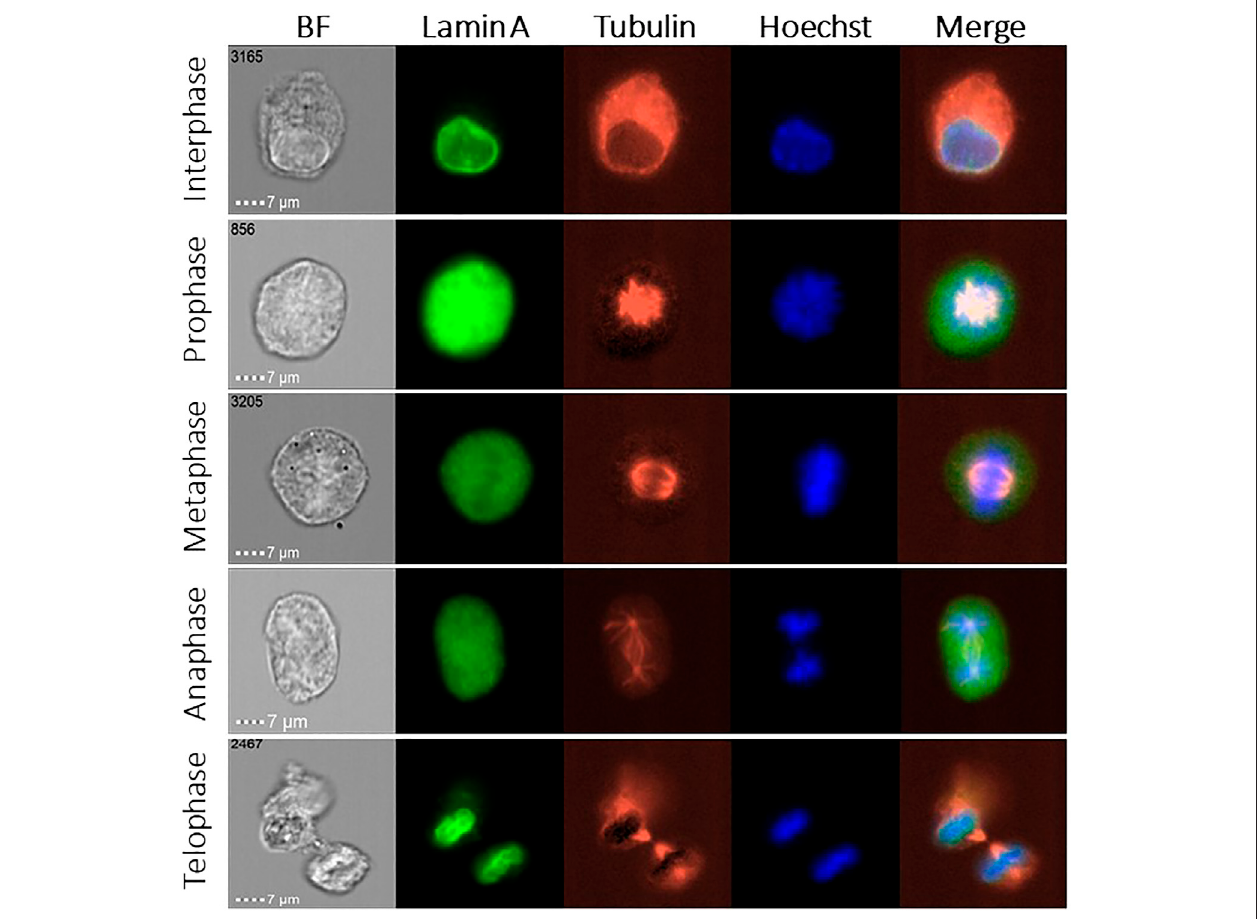
FIGURE1| ImageStreamimages ofthecellcyclephases inMEFcells. Representative fl uorescence imagesoflaminA(green), tubulin(red), and chromatin (blue) in 5 different stages of the cell cycle, together with the bright fi eld (BF) image. Merged images show the lamin A, chromatin, and tubulin localization.